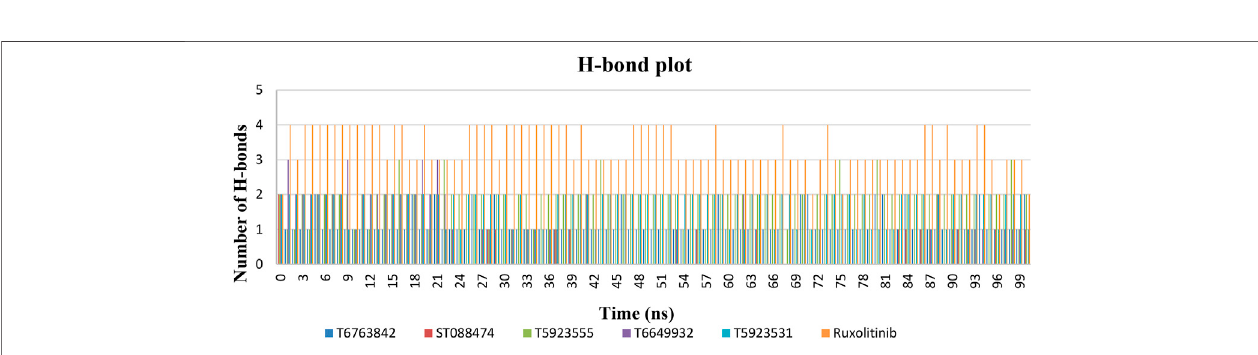
FIGURE 8 | The change in SASA values over a period of 100 ns after binding with the lead compounds and drug.